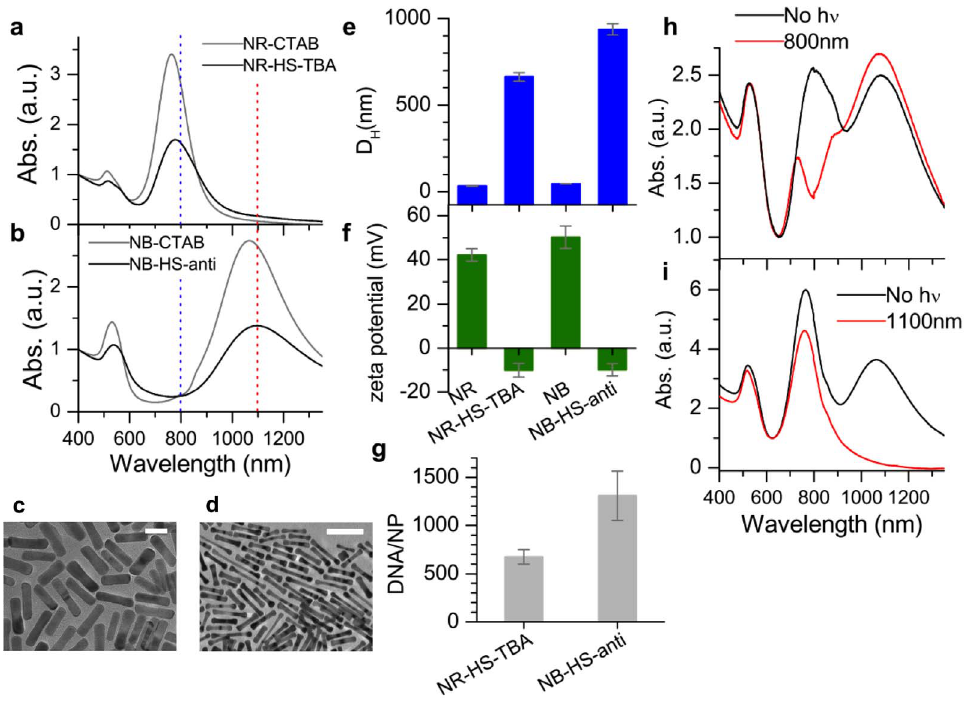
Figure 2. Gold nanoparticles synthesized and loaded for triggered release. Absorption spectra of a) NRs, NR-HSA-TBA coronas (LSPR max =777 nm), b) NB, NB-HSA-antidote (LSPR max =1093 nm). c) TEM image of NRs, scale bar =20 nm, d) TEM image of NBs, scale bar =100 nm, e) D H (DLS) of NRs, NR-HS-TBA, NBs, NB-HS-antidote, indicating that a corona contains multiple not a single NR or NB, but multiple ones. f) Zeta potential of NRs, NR-HS-TBA = 2 9.8 mV, NBs, NB-HS-antidote = 2 10.1 mV g) Quantified DNA payloads of NR-HS-TBA (674 6 74 TBA/NR), NB-HS-antidote (1307 6 255 antidote/NB). h) mixture of NR-CTAB + NB-CTAB before (black) and after (red) 800 nm irradiation. i) NR-CTAB + NB-CTAB before (black) and after (red) 1100 nm